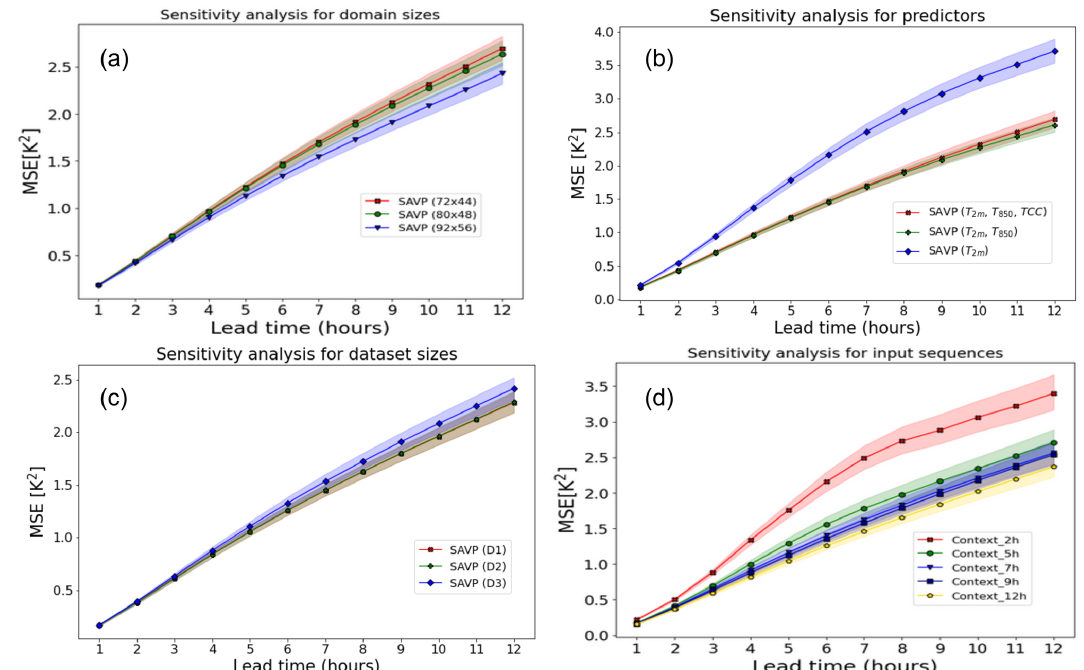
Figure 10. Averaged MSE of 2m temperature forecasts with the SAVP model for different sensitivity experiments using (a) different domain sizes (red – 92 × 56; green – 80 × 48; blue – 72 × 44), (b) different predictors (red – T 2m , T 850hPa , and TCC; green – T 2m , T 850hPa ; blue – T 2m ), (c) different sizes of the training dataset (red – 11 years; green – 10 years; blue – 8 years), and (d) different input sequence lengths. The sampling uncertainty estimated via block bootstrapping is denoted by colour